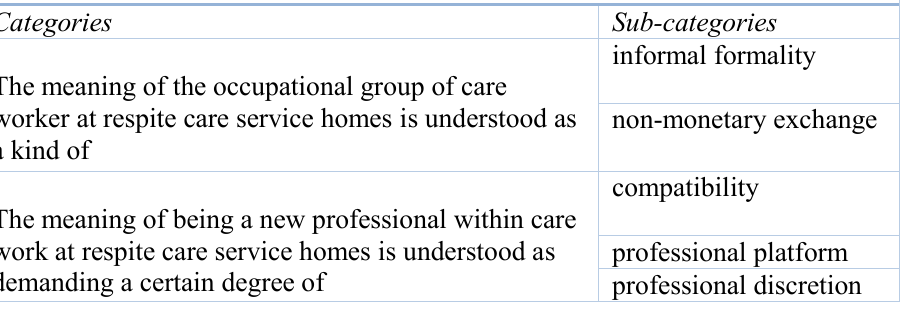
Table 2 The research findings presented as theme, categories, and sub-categories